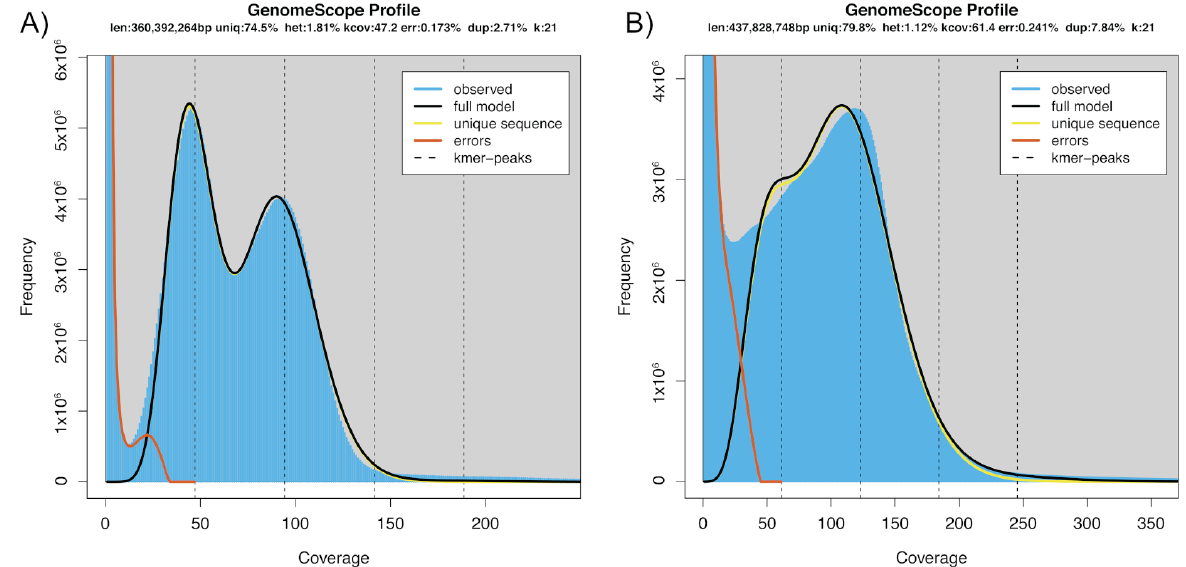
Figure 1. GenomeScope k-mer profile plots for short-read PE libraries illustrating the distribution of 21-mers in ( A ) 169 bp insert size PE data and ( B ) 260 bp insert size PE